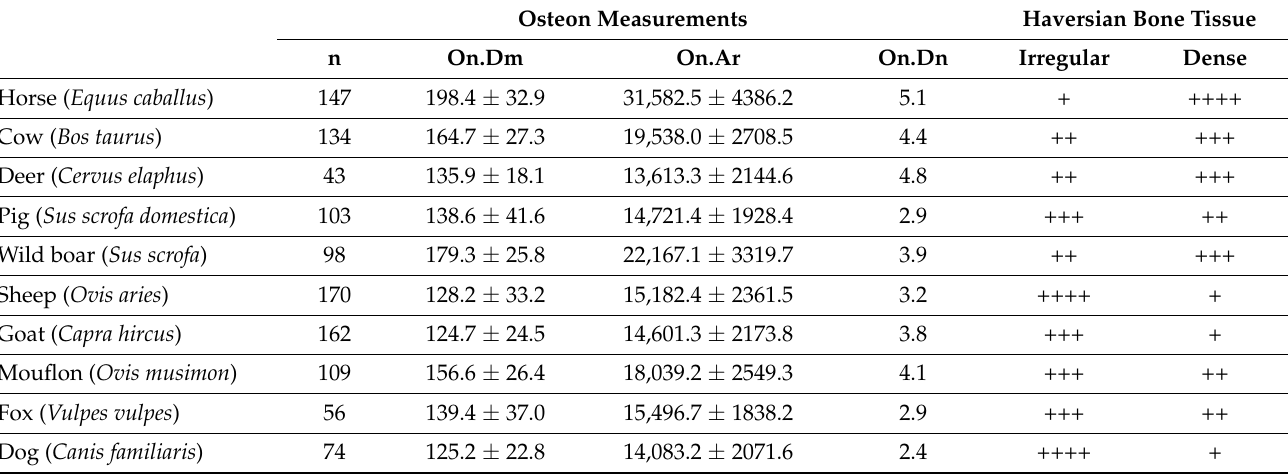
Table 1. Histomorphometrical data of the Haversian bone tissue in different species 1 . Osteon Measurements Haversian Bone Tissue n On.Dm On.Ar On.Dn Irregular